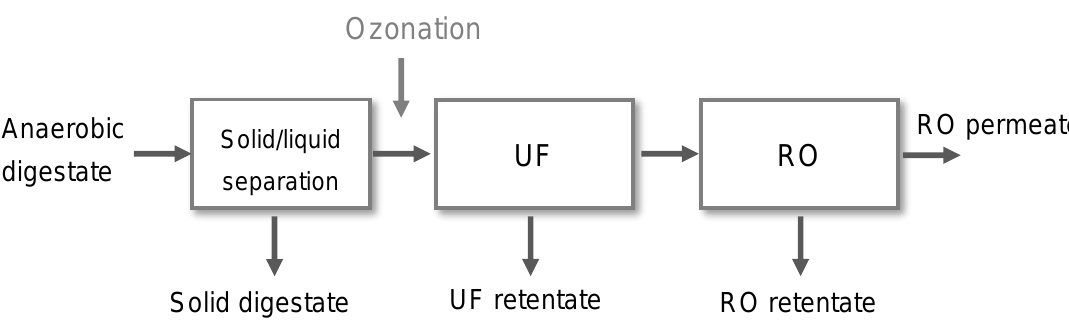
Figure 1. Process scheme of the membrane-based nutrient recovery process.